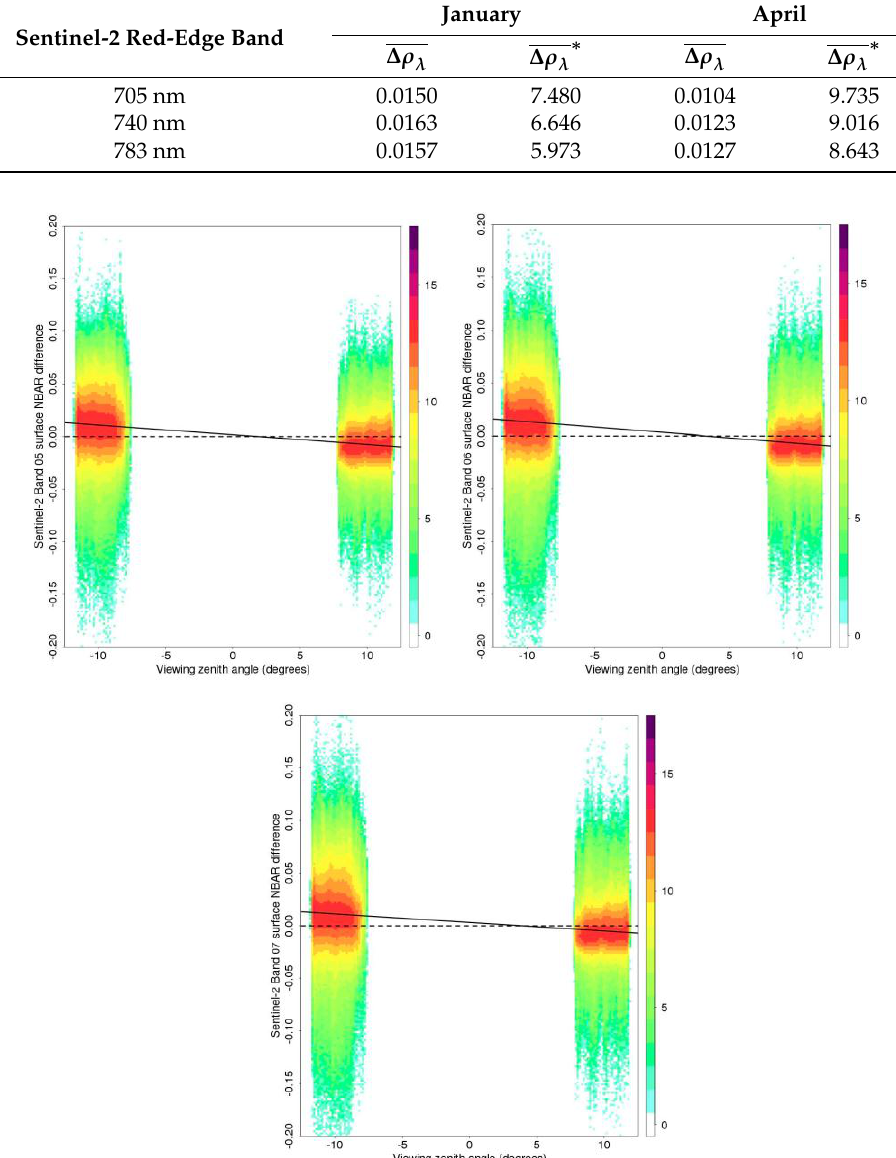
Table 7. Mean absolute reflectance differences (Δρ λ )̅̅̅̅̅̅ (Equation (5)) and mean absolute relative percentage differences (Δρ λ ̅̅̅̅̅̅ ) (Equation (6)) between the pairs of forward and backward scatter Sentinel-2A surface NBAR values illustrated in Figures 6 and 7. A total of 6,600,685 and 10,656,197 pairs of forward and back scatter surface NBAR values were considered in January and April, respectively.